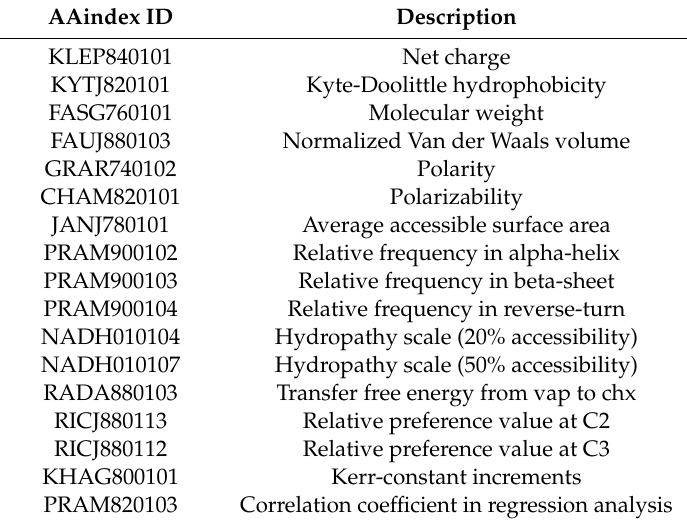
Table 3. Biochemical features for amino acids in protein targets.